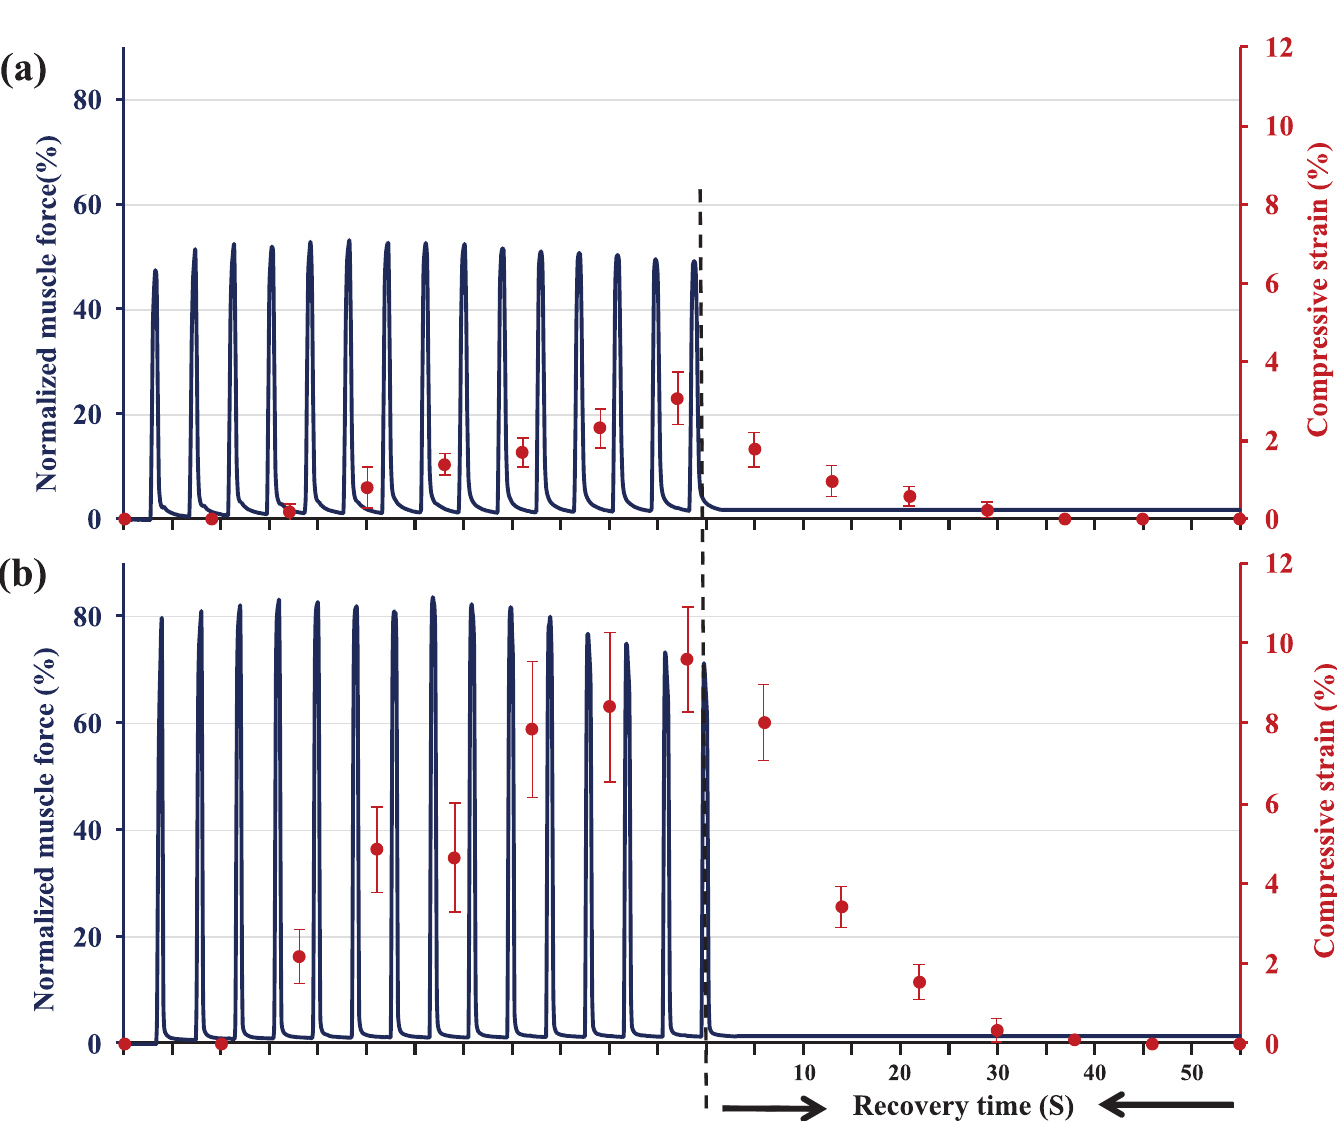
Fig 4. Normalized (relative to maximum = 100%) knee extensor forces as a function of time. Muscles were stimulated 15 times for 0.5s every 4s at a voltage and frequency producing approximately (a) 50% of the maximal muscle force. Cartilage compressive strain (mean ± 1SD; n = 6) increased as a function of the number of muscular contractions. Full cartilage recovery takes around 20s upon unloading. (b) Loading using approximately 80% of the maximal isometric force. Cartilage strain (mean ± 1SD; n = 6) increased with increasing the number of muscular contractions and reached its maximum at the last contraction. Cartilage tissue recovered to its original shape within approximately 35s following force